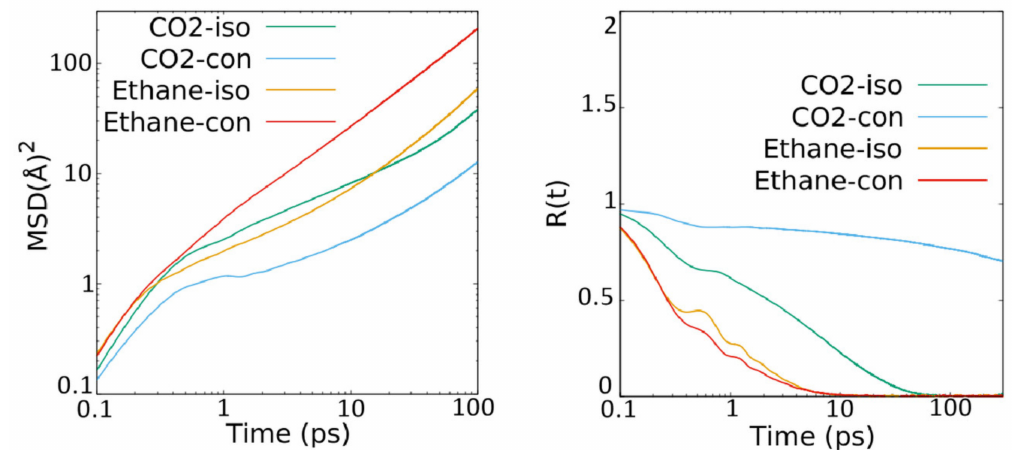
Figure 7. MSD ( left ) and R(t) ( right ) of ethane and CO 2 in ZSM-22 at a loading of 72 molecules in the simulation cell. In the legend, the suffices “iso” and “con” are used to distinguish between the simulations involving unmodified ZSM-22 with isolated pores and ZSM-22 modified by inserting inter-crystalline space that results in the pores being connected via the inter-crystalline